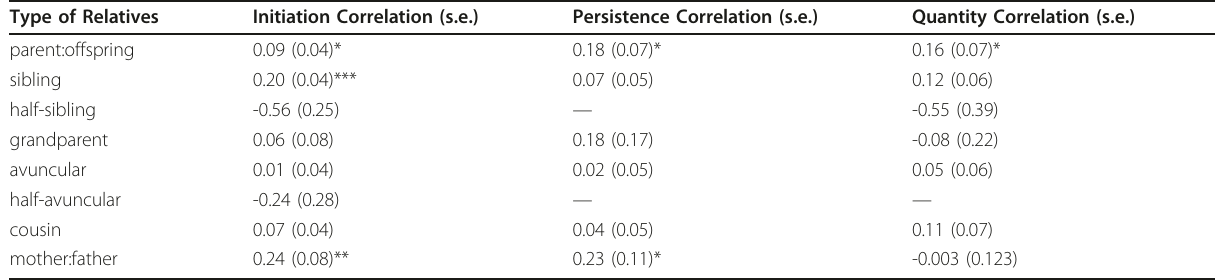
Table 2 Interclass and intraclass correlations in different pairs of relatives for smoking initiation, persistence, and quantity.